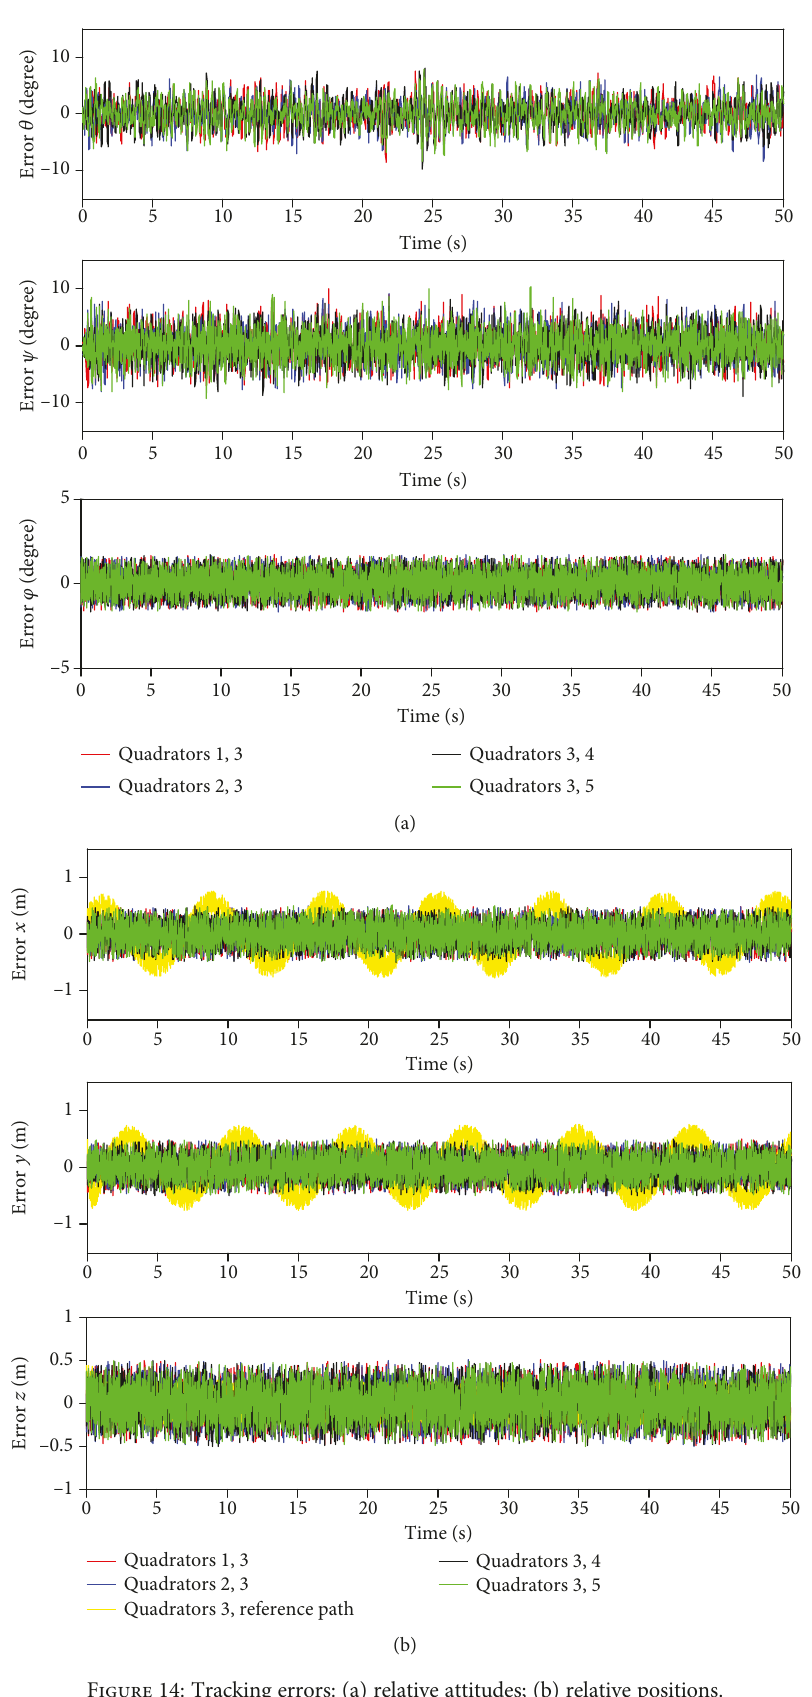
Figure 14: Tracking errors: (a) relative attitudes; (b) relative